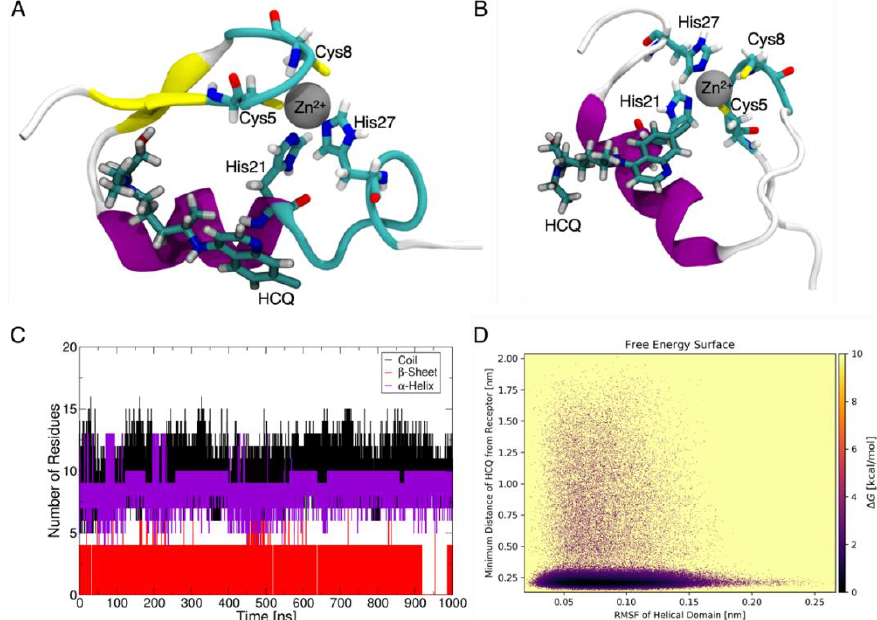
Figure 10. Representative structures of HCQ-bound zinc-finger motif showing ( A ) HCQ disrupting the α -helical domain during the first 500 ns of room temperature dynamics in water, and ( B ) HCQ interacting with Zn 2+ ion causing temporary unfolding of the β -sheet domain during the second 500 ns of dynamics. ( C ) Timeline of number of residues in coil, β -sheet and α -helix conformation for the full microsecond dynamics of zinc-finger motif with HCQ. ( D ) Free energy map of HCQ– zinc-finger distance against root mean square fluctuation (RMSF) of the α -helical domain showing exclusively large RMSF only with bound